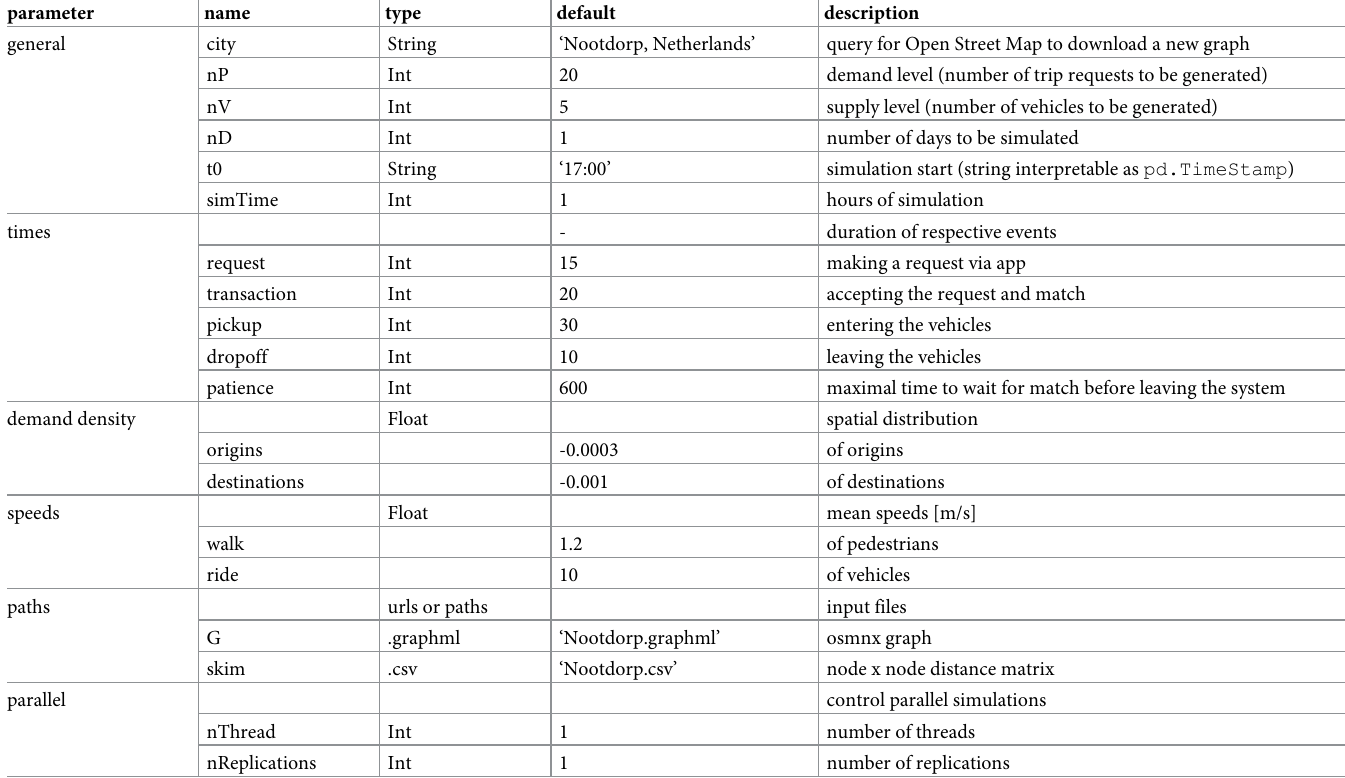
Table 1. Default parameterization of MaaSSim and parameters’